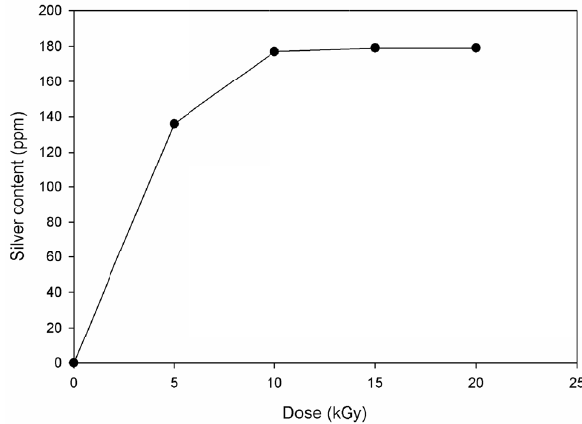
Fig. 1. Relationship between the content of AgNPs on the silk fabrics and irradiation